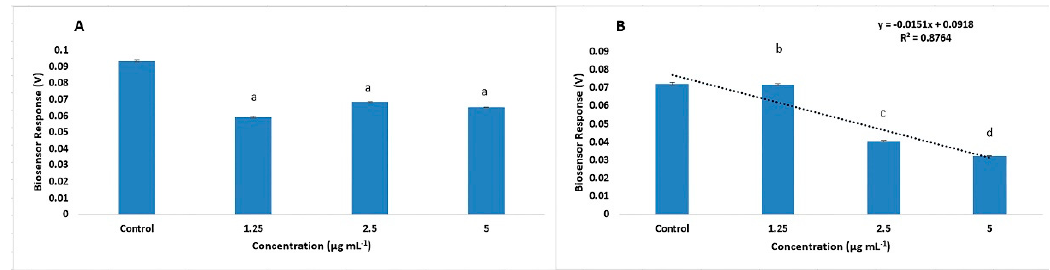
Figure 2. Biosensor response against standard solutions of acetamiprid. Zero acetamiprid concentration was considered as control. Non − engineered Vero cells (i.e., bearing no acetamiprid − specific antibodies) did not show specific responses to the presence of acetamiprid at increasing concentrations ( Α ). On the other hand, membrane − engineered cells with antibodies against acetamiprid responded to dilutions of acetamiprid with considerable membrane hyperpolarization ( Β ). (Pictured is n = 12 replication for each sensor for each different concentration and error bars represent standard errors of the average value of all replications: 768 time − series). Columns with same letters indicate statistically non − different values ( p < 0.05) and columns marked with different letters indicate significantly different values ( p < 0.05).